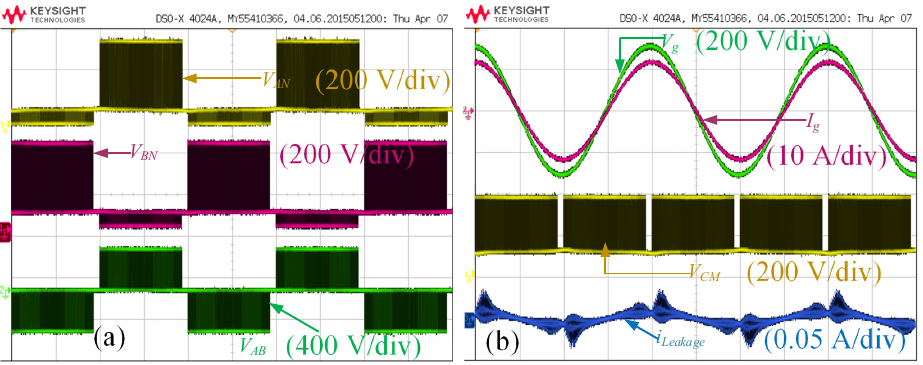
Figure 15. Steady-state response of the proposed inverter: ( a ) V AN , V BN , and V AB ; ( b ) grid voltage ( V g ), grid current ( i g ), common-mode voltage ( V CM ), and leakage current ( i Leakage ).